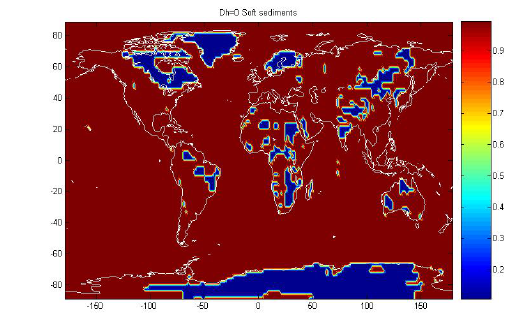
Table 2. Polyhedral modeling results of hard